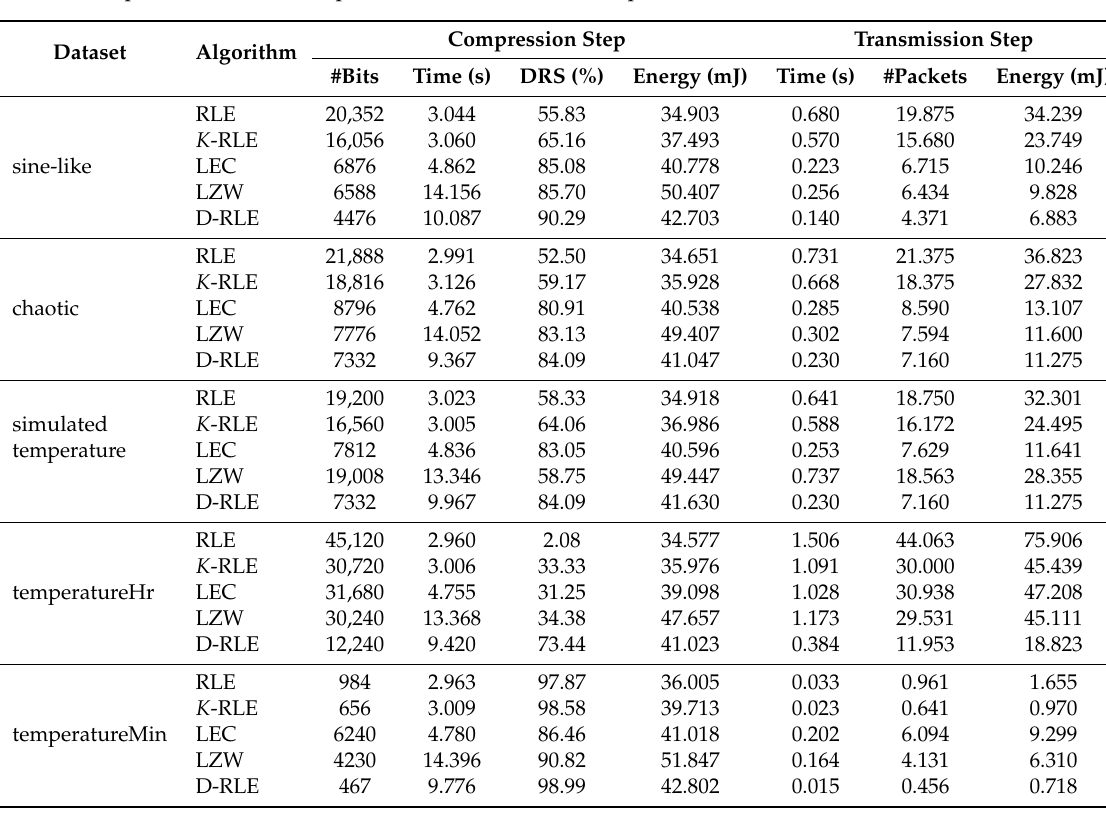
Table 7. Comparison between compression and transmission steps for datasets with the same size of 46,080 bits.